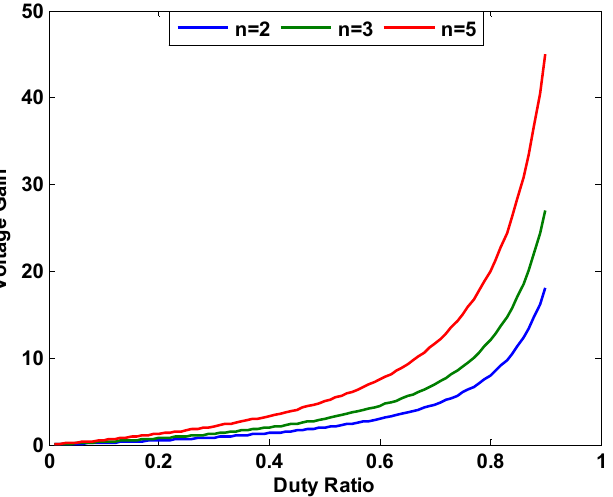
Figure 4. Variation of voltage gain with duty ratio at different number of converter stages.